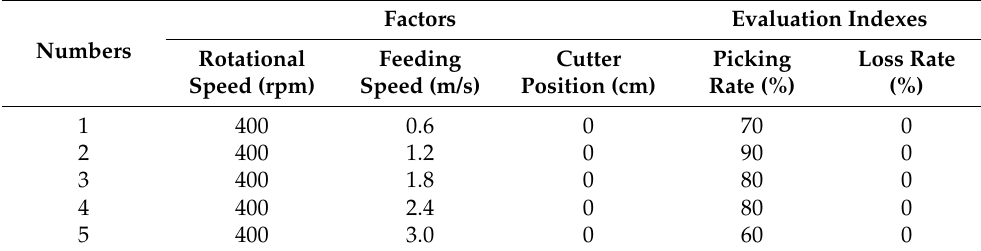
Table 2. Results of the single-factor test of the stalk feeding speed.